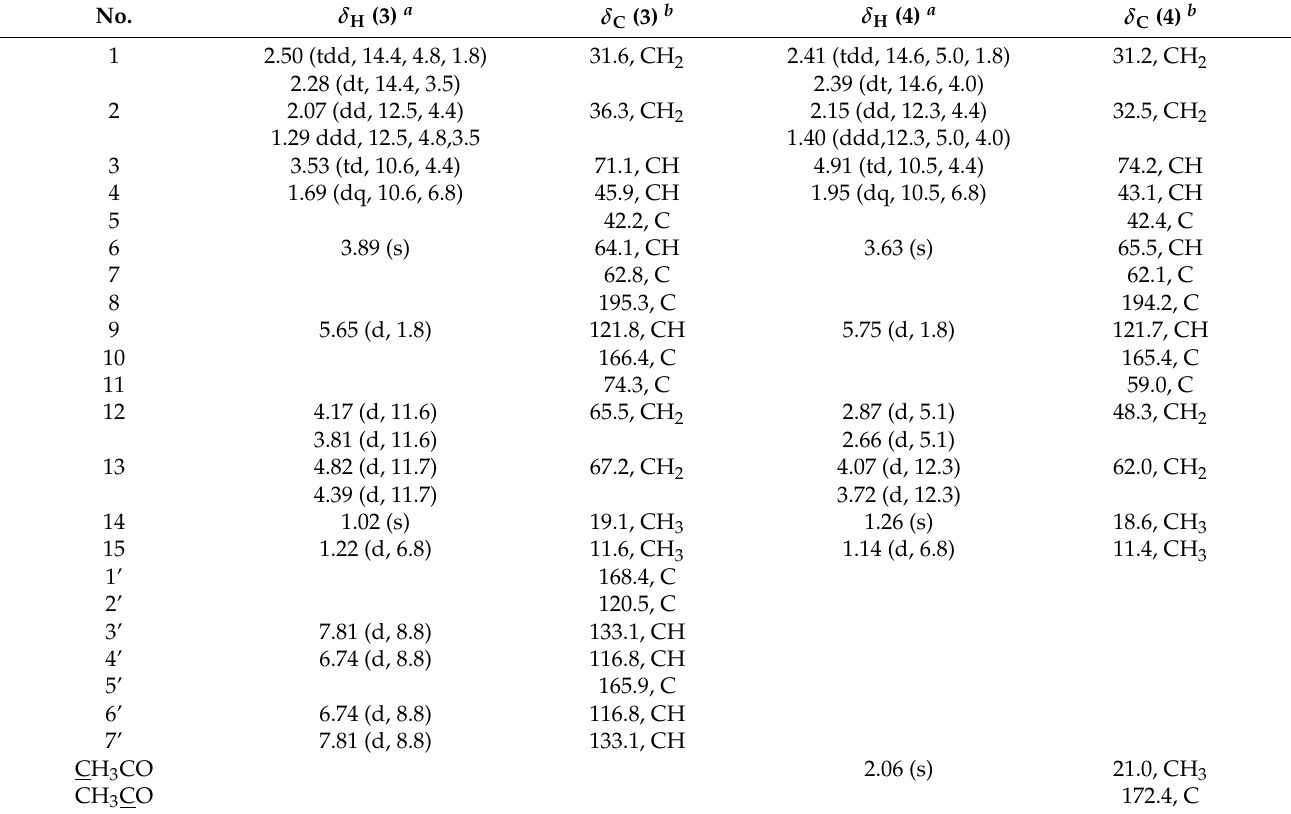
Table 2. 1 H and 13 C NMR Spectroscopic Data for 3 and 4 in Methanol- d 4 ( δ in ppm, J in